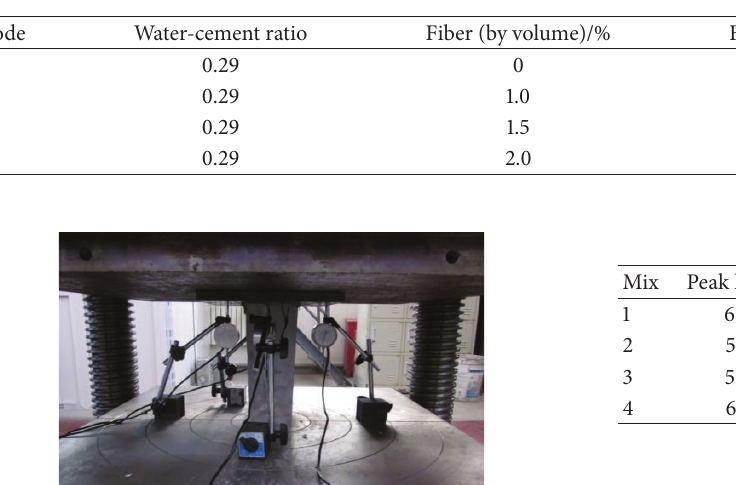
Table 2: Mix of test.